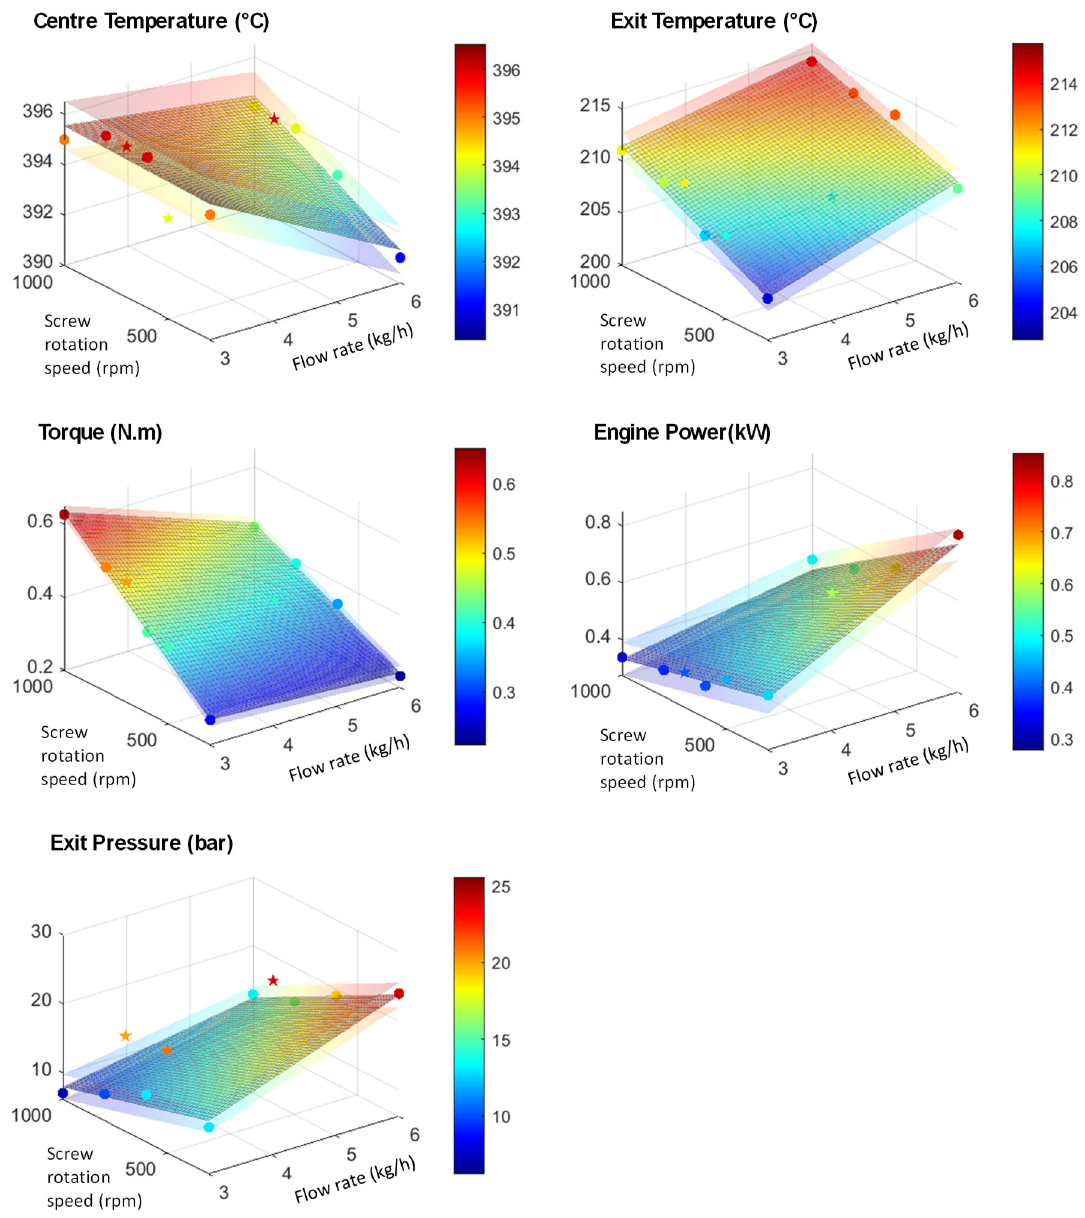
Figure 13. Results obtained with the stochastic method coupled to SVR. The dots correspond to training values, and the stars correspond to test